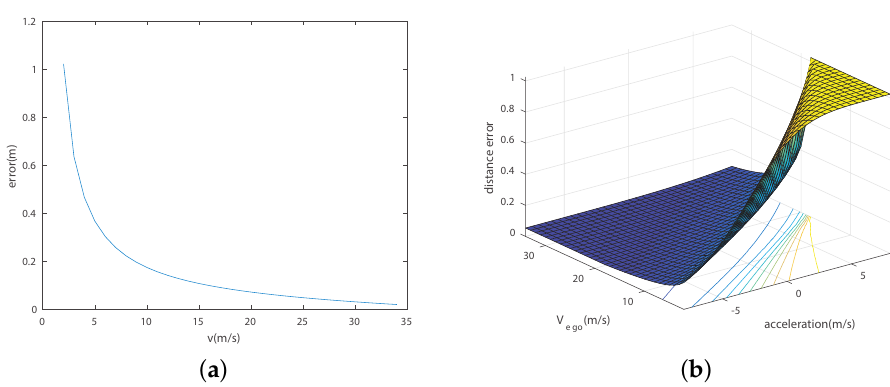
Figure 18. The longitudinal distance errors of the evasive motion model. ( a ) The distance errors at different constant speeds. ( b ) The distance errors at different accelerations.